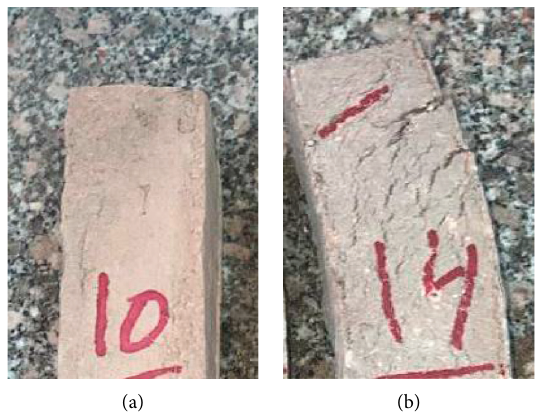
Figure 10: Specimens fired at 1000 ° C and containing different percentages of GBFS. (a) 20% slag; (b) 30%